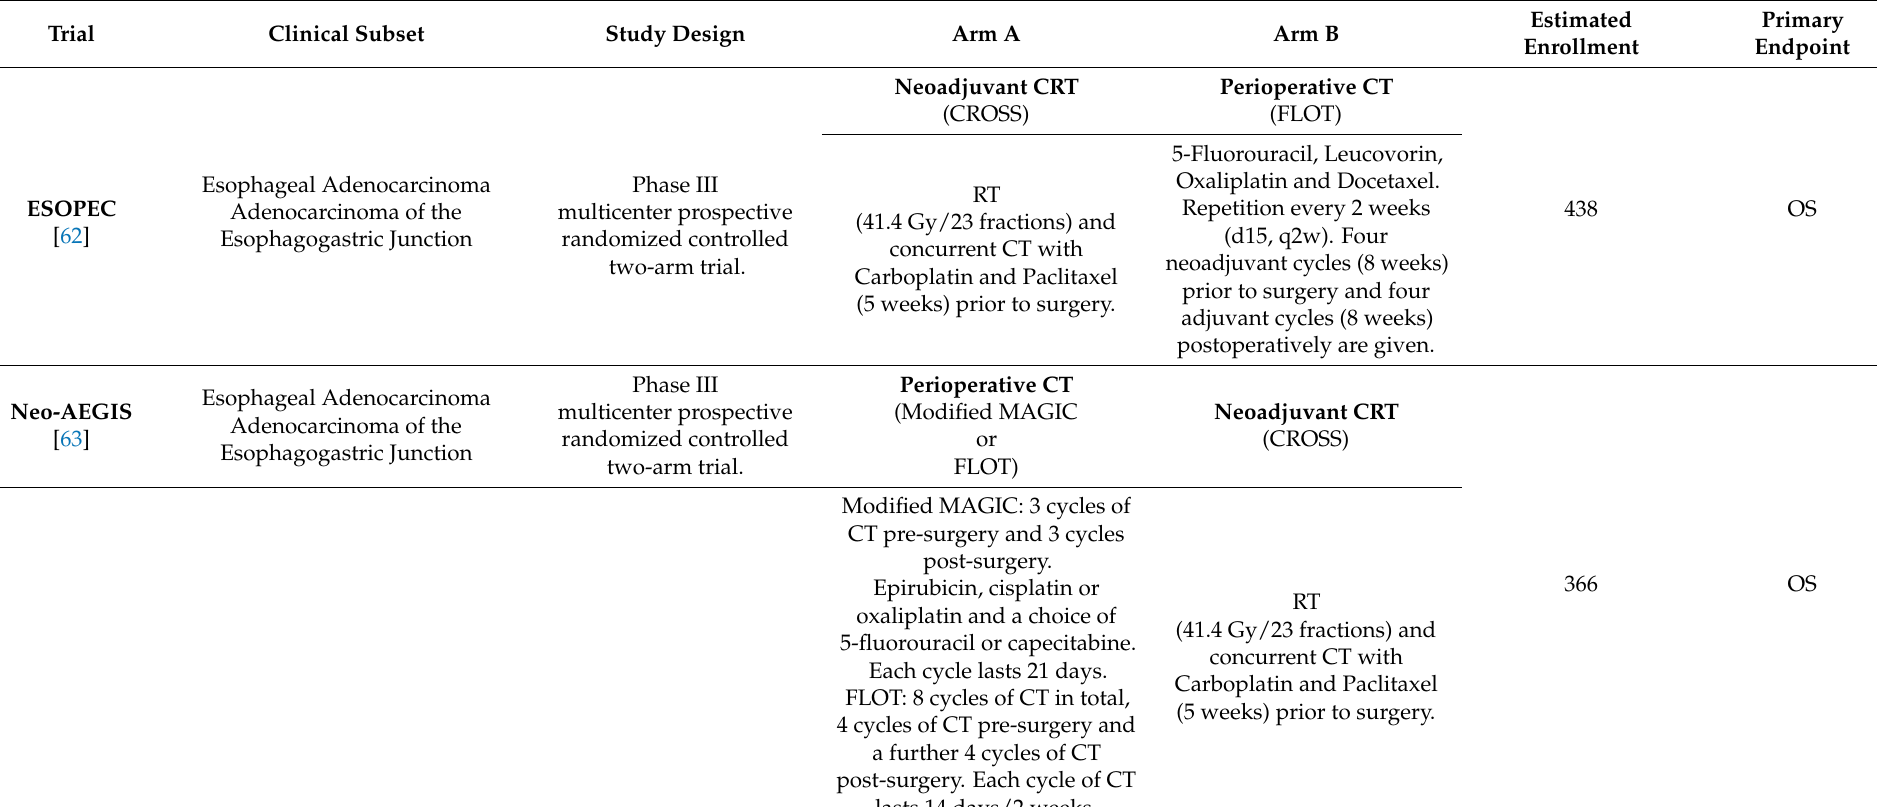
Table 1. Design and main characteristics of ongoing trials for pre-operative radiochemotherapy in esophageal and gastroesophageal cancer.